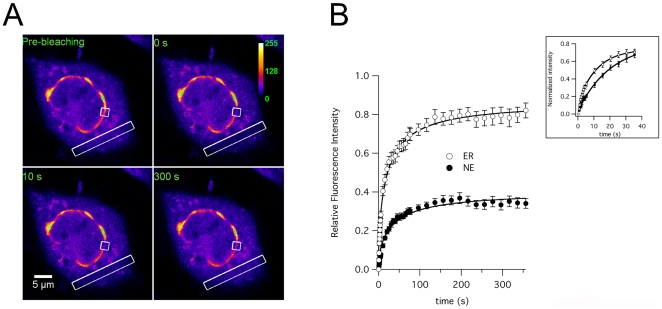
Quantitative FRAP analysis of lateral diffusion of KV10.1 in CHO cells transiently expressing KV10.1-mVenus.A. Example of the photobleaching process in the perinuclear region and ER (boxes). The recovery is shown at 0, 10 and 300 seconds after bleaching. B, Lower panel shows the average normalized fluorescent intensity during recovery from all cells (±s.e.m.). The first 10 data points were taken every 0.47 seconds, the next 15 every 5 seconds and the last 15 every 20 seconds. The black solid lines are the result of fitting as described in Material and Methods. The initial 40 seconds of recovery are shown normalized in the inset.